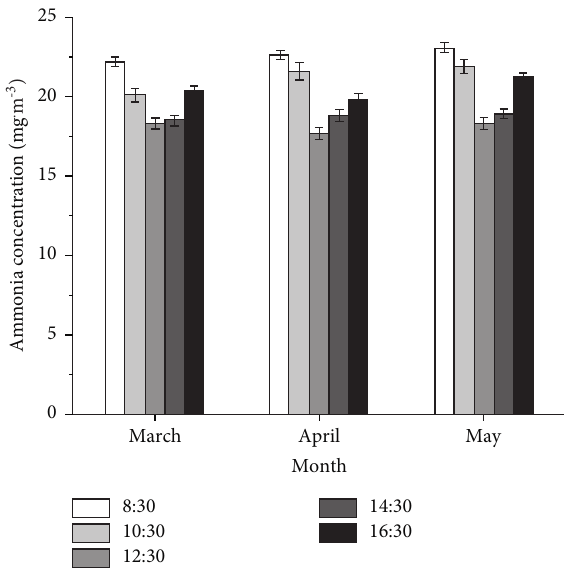
Figure 4: Monthly changes in ammonia